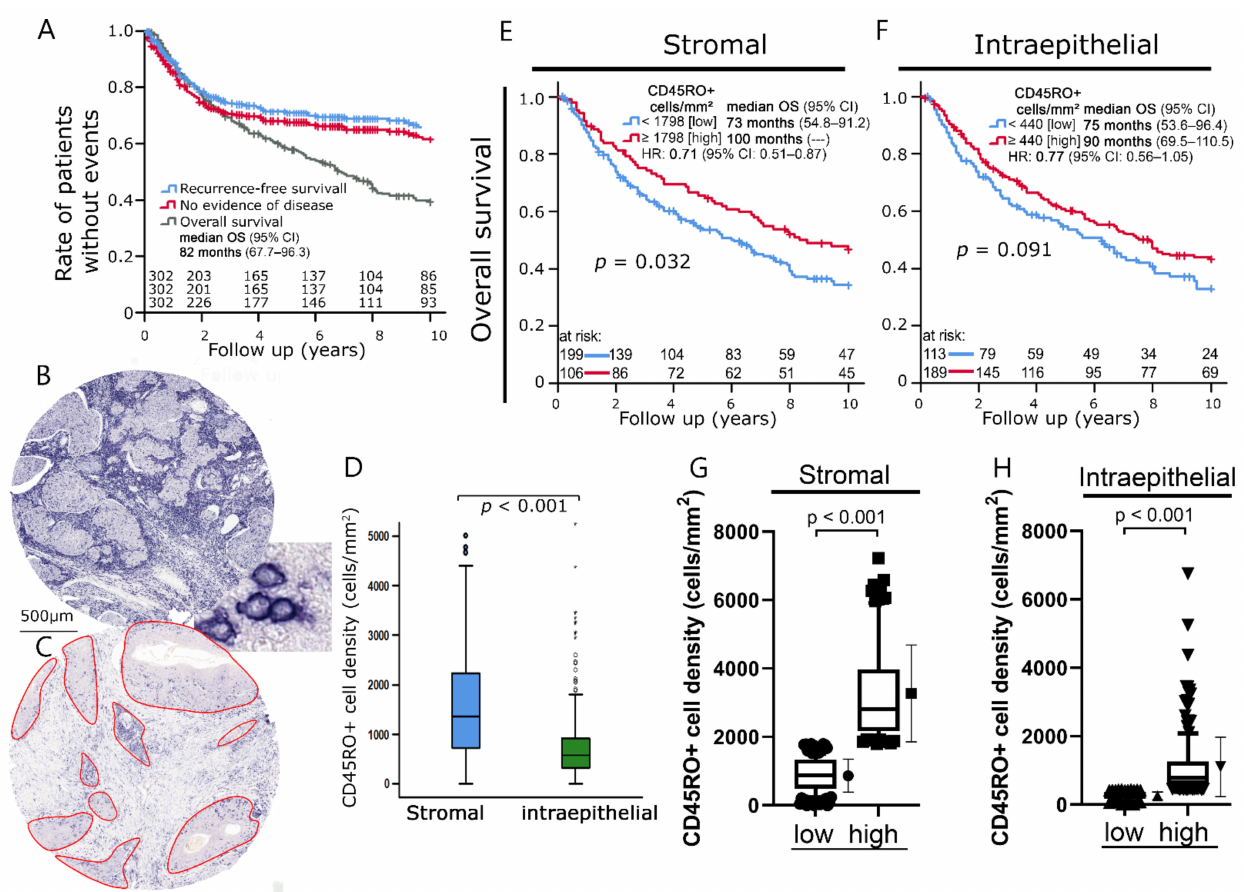
Figure 1. ( A ) Kaplan–Meier plots of 10-year survival of the analyzed cohort divided into overall survival, recurrence-free survival, and no evidence of disease. ( B ) Representative image of a tissue spot from a tissue microarray (TMA) with distinct stromal CD45RO+ cell infiltration. The bottom right window depicts examples of CD45RO+ cells stained by immunohistochemistry. ( C ) Representative image of a tissue spot with weak stromal infiltration. Intraepithelial compartment highlighted by image analysis software. ( D ) Boxplots of stromal and intraepithelial CD45RO+ cell densities in head and neck tumors. The black horizontal line between the two boxplots indicates significant differences between mean values. ( E , F ) Kaplan–Meier plots of overall survival according to CD45RO+ cell densities in the ( E ) stromal and ( F ) intraepithelial compartment. ( G , H ) Boxplots of